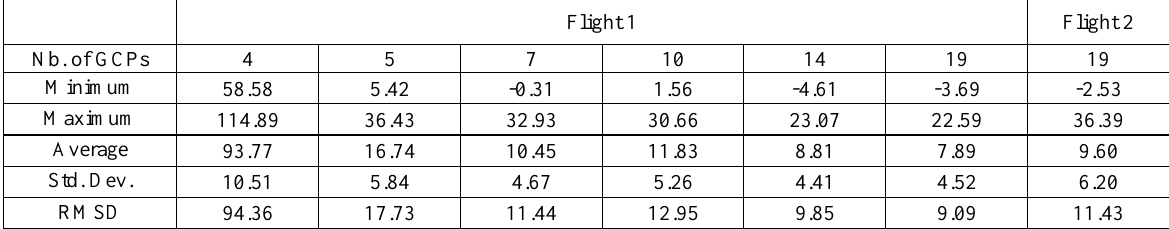
Table 3. Statistics of the vertical discrepancies assessed with the profile (GNSS data vs. DSMs data). All values are in